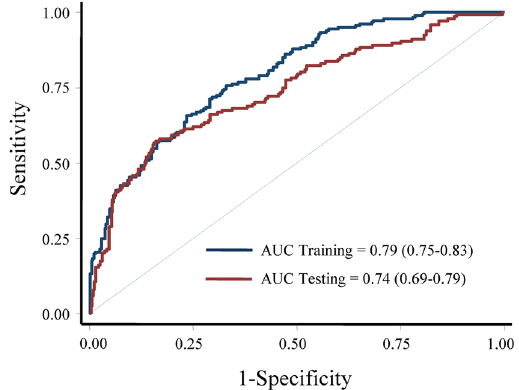
Figure 2. Assessment of model performance. The receiver operating characteristics curves were used to assess the performance of the final model in the training and testing sets.